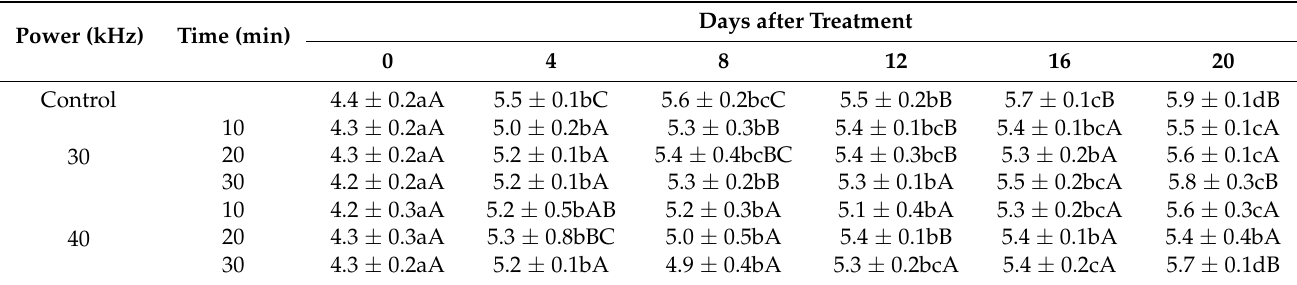
Table 2. Titratable acidity (g citric acid/100 g of pulp) during storage at 4 ◦ C of Passiflora edulis f. edulis Sims ( gulupa ) pulp subjected to low-frequency ultrasound treatments.